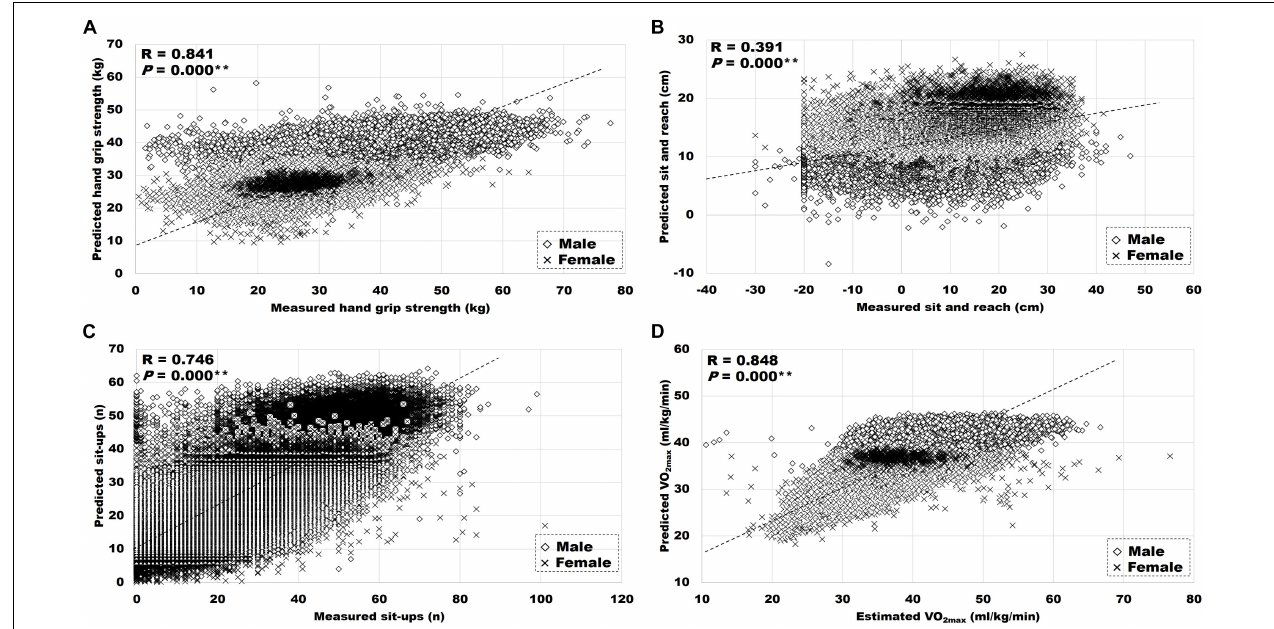
FIGURE 1 | Relationship between measured or estimated, and predicted HRPF. (A) Hand grip strength. (B) Sit and reach. (C) Sit-ups. (D) VO 2 max . Significant correlation between measured or estimated and predicted variables, ** P < 0.01.